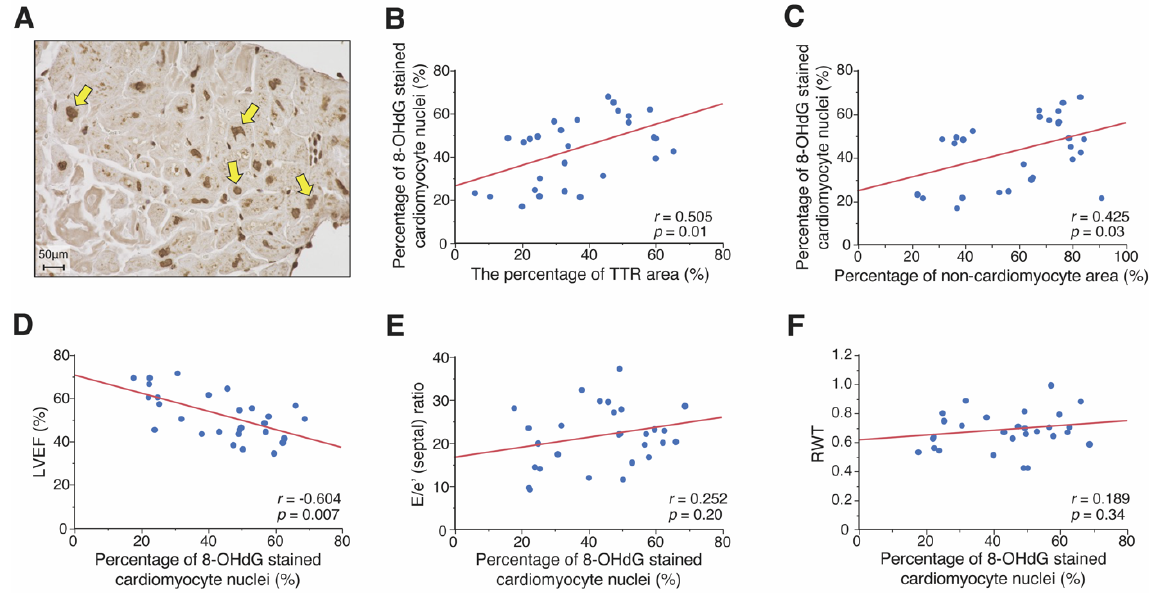
Figure 3. The association between immunostaining of 8-hydroxy-2 ′ -deoxyguanosine (8-OHdG) and echocardiographic parameters in patients with ATTR-CM. ( A ) Immunostaining for 8-OHdG, visualized by diaminobenzidine (brown). 8-OHdG was found to be expressed in cardiomyocyte nuclei (Arrowheads). The relationship between the percentage of 8-OHdG stained cardiomyocyte nuclei and ( B ) percentage of TTR area, ( C ) the percentage of non-cardiomyocyte area, ( D ) LVEF, ( E ) E/e’ (septal) ratio, and ( F ) RWT. ATTR-CM, transthyretin amyloid cardiomyopathy; E/e’ (septal) ratio, early transmitral filling velocity (E)/peak early diastolic velocity of the septal mitral annulus (e’) ratio; LVEF, left ventricular ejection fraction; RWT, relative wall thickness; TTR, transthyretin.